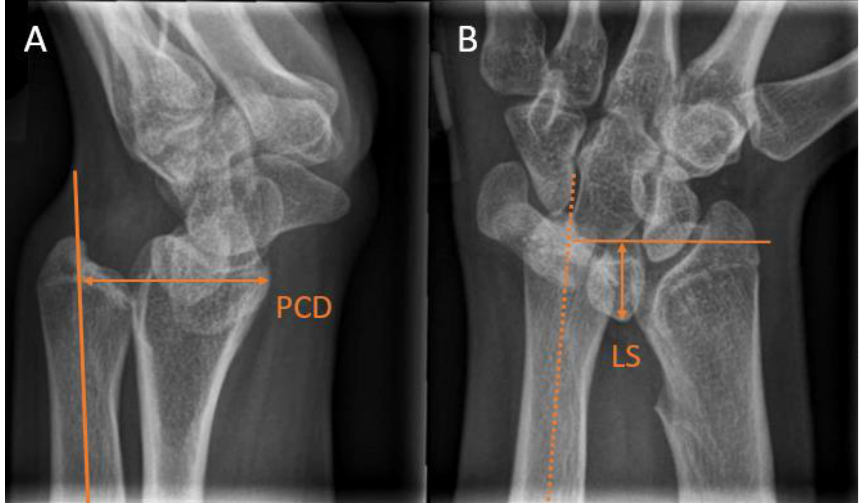
Figure 6. Radiographic wrist measurements used for the assessment of Madelung deformity. ( A ) Palmar carpal displacement (PCD) on a lateral wrist view, measured as the distance between the longitudinal ulna axis and the most volar lunate aspect. ( B ) Lunate subsidence (LS) on a posterioanterior view, measured as the distance between a perpendicular line to the longitudinal ulna axis and the most proximal lunate point.